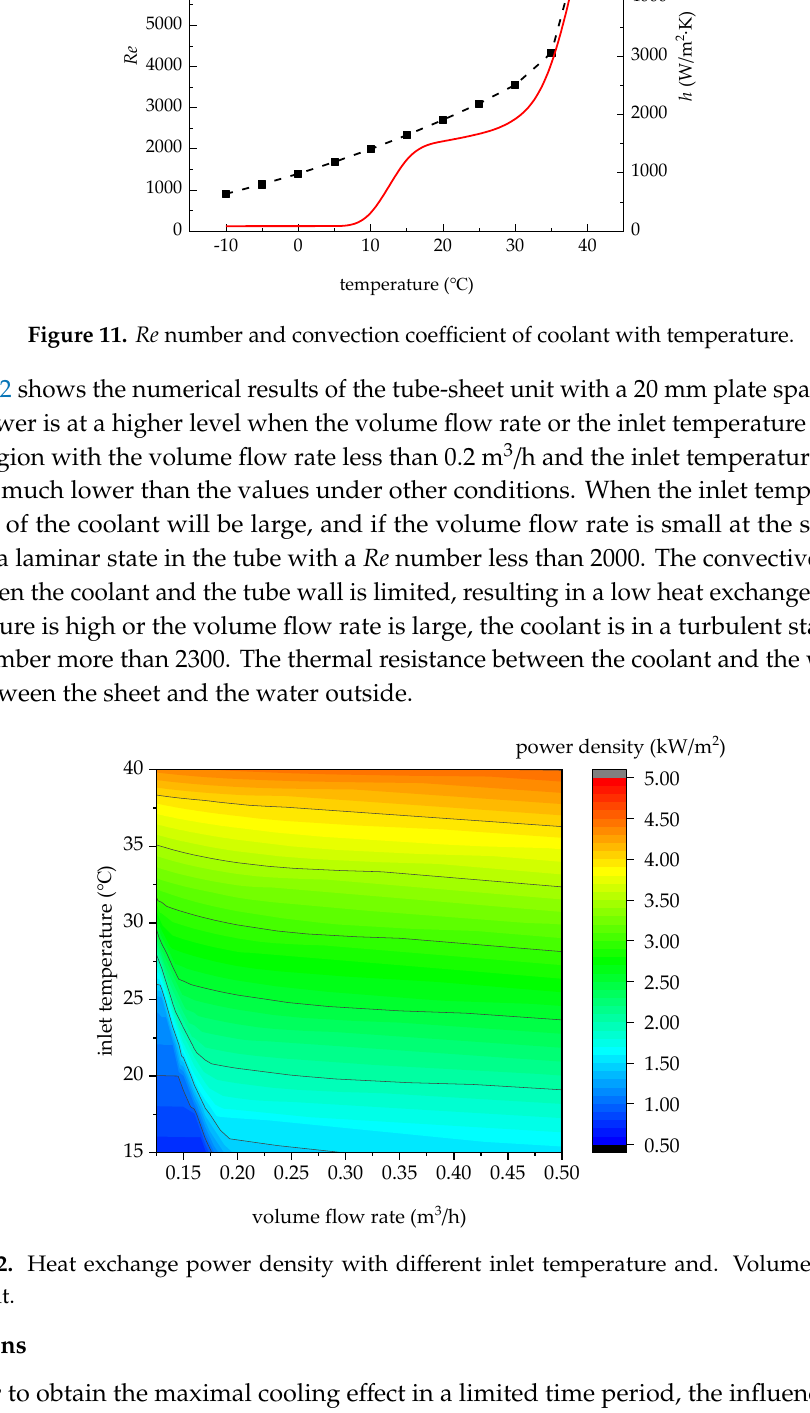
Figure 10. Effects of coolant conditions on heat exchange power density. ( a ) volume flow rate = 0.5m 3 /h. ( b ) inlet temperature = 20 °C.